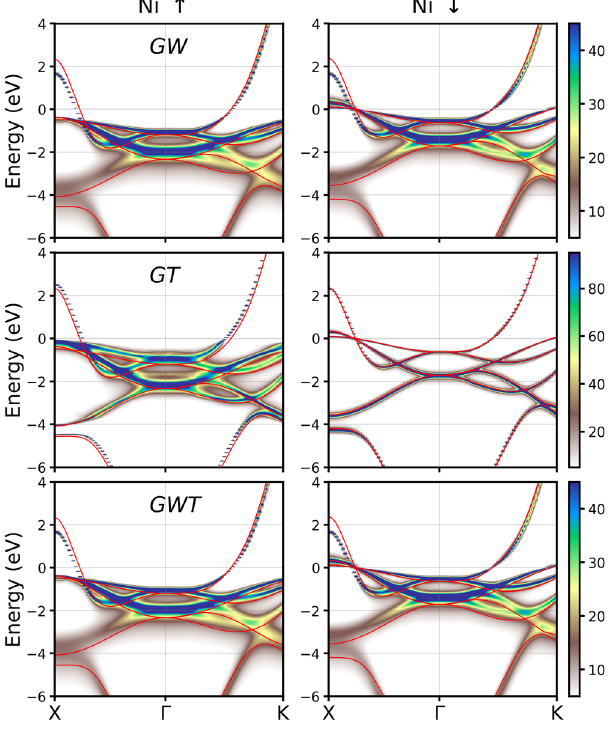
Fig. 8 Renormalized band structures of fcc Ni. Spin-dependent band structures are renormalized with GW , GT , and GWT self- energies along X − Γ −